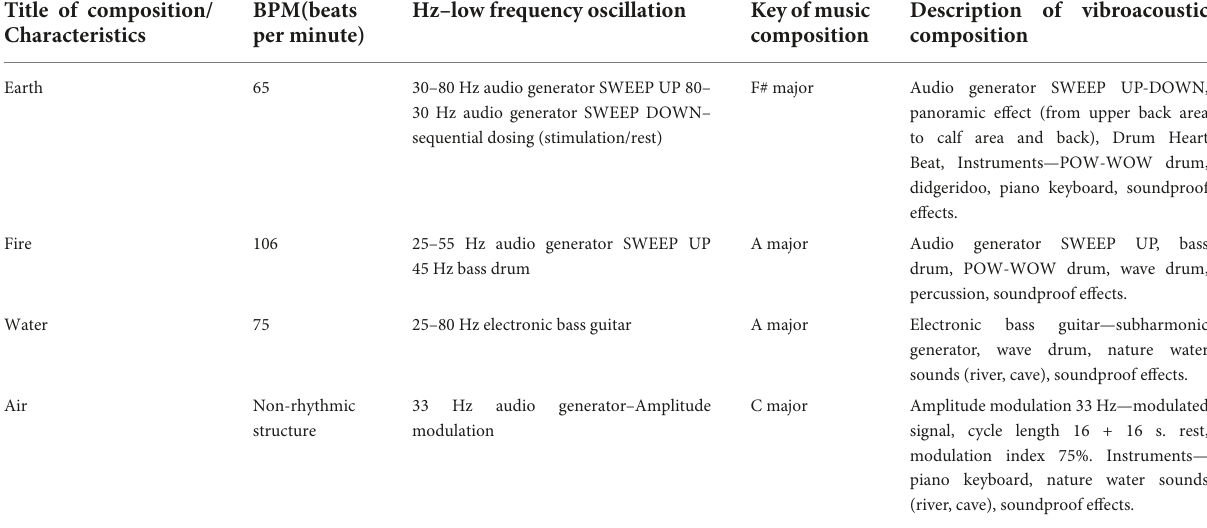
TABLE 1 The vibroacoustic recording called